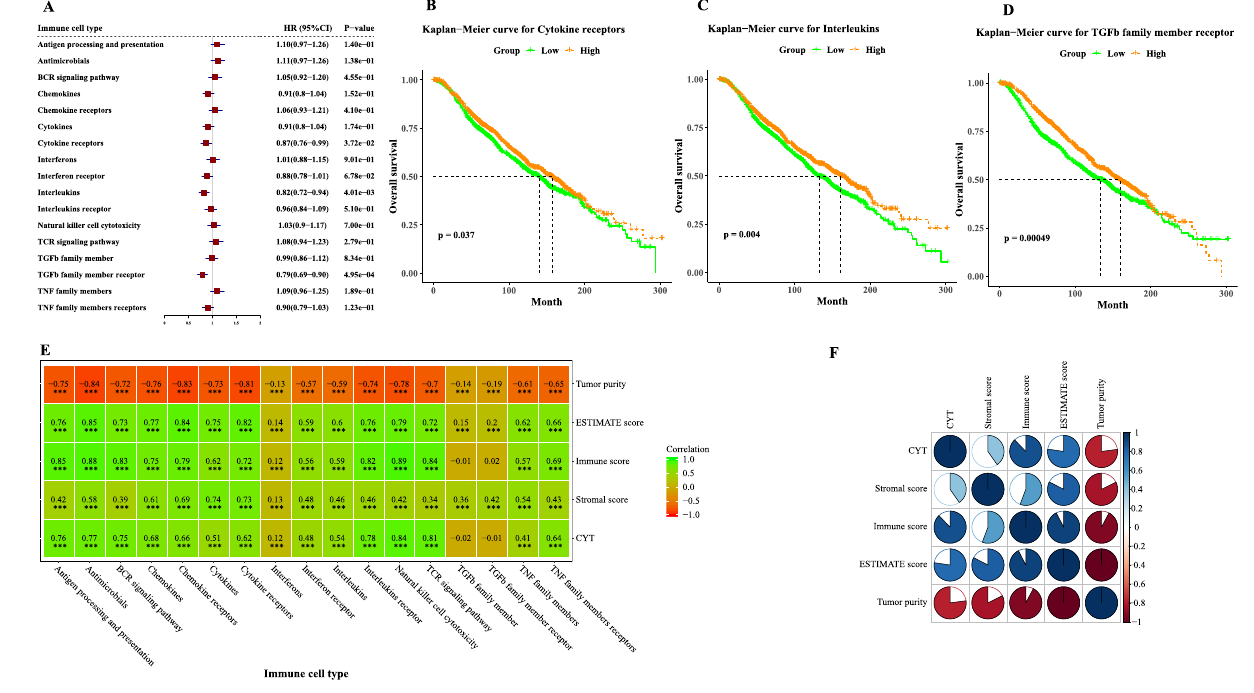
Figure 1. The immune landscape of 17 immune cell types. ( A ) Forest plot visualizing hazard ratios (HRs) with 95% CI and P-values for 17 immune cell types. Kaplan-Meier survival curves by high and low tumor infiltrating levels for (B) cytokine receptors, (C) interleukins and (D) TGFb family member receptor. (E) The spearman’s correlation between the tumor infiltrating levels of 17 immune cell types and tumor purity, ESTIMATE score, stromal score, immune score and CYT. Statistical significance at the level of null ≥ 0.05, * < 0.05, ** < 0.01 and *** < 0.001. (F) The Spearman’s correlation between tumor purity, ESTIMATE score, stromal score, immune score and